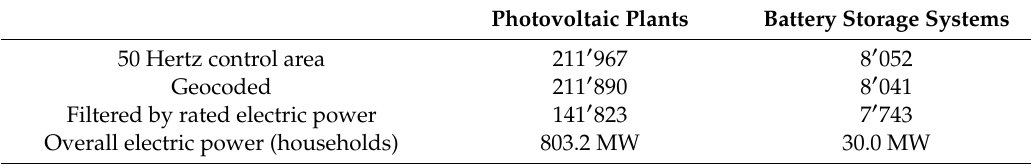
Table 1. Units and rated electric power—results from geocoding and